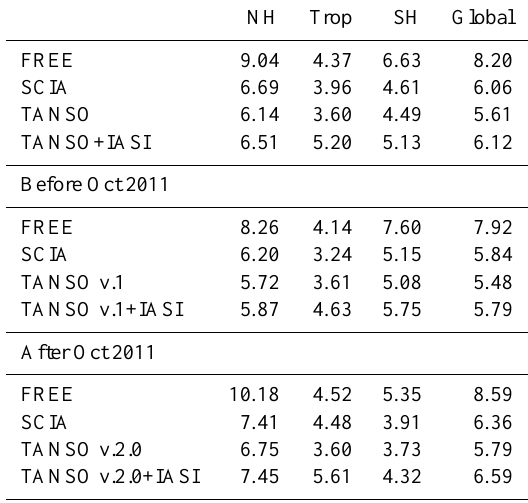
Table 4. Same as Table 3 but for the standard